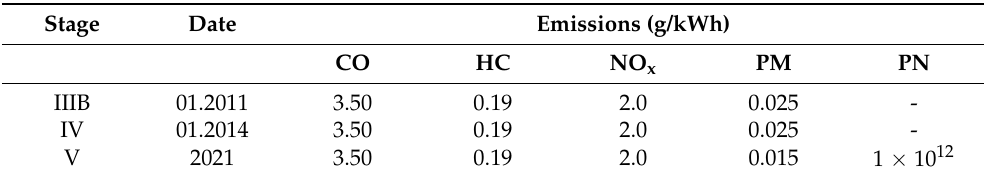
Table 2. Evolution of the emission standard limits for non-road diesel engines in the power range 130–560 kW.